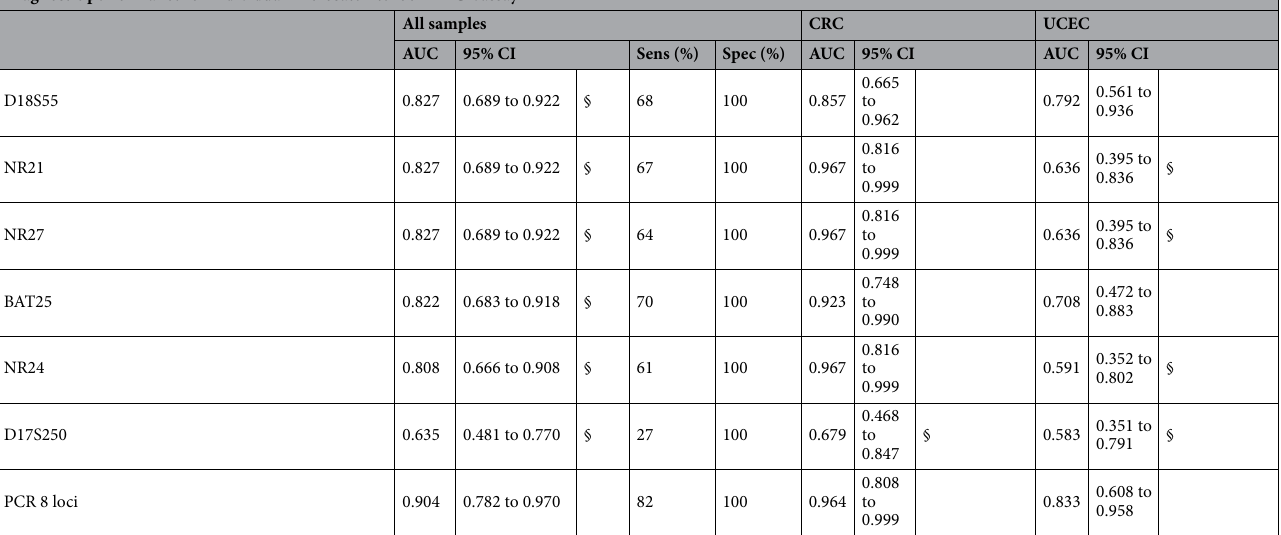
Table 2. Diagnostic performance of individual microsatellite loci within the panel-based assays in colorectal (CRC) and uterine corpus endometrial (UCEC) cancer. Area under the ROC curve (AUC) with 95% confidence intervals (CI) for prediction of MMR status using IHC as reference test were calculated for the 10, 7 and 8 individual microsatellite loci in the NGS, Idylla MSI and PCR test and statistically compared to the integrative result for each of the three molecular panel-tests. This was done for all samples (n = 49) with calculation of sensitivity (Sens%) and specificity (Spec%), and separately for both tumor types. § indicates significantly different (P < 0.05) AUC for the individual locus as compared to the integrative result of the corresponding panel test. AUC area under the receiver operating characteristics (ROC) curve, 95% CI 95% confidence interval, Sens sensitivity, Spec specificity. § Indicates significantly different AUC ( P < 0.05) of individual microsatellite locus versus integrated result over 10, 7 and 8 loci for NGS, Idylla MSI assay and PCR